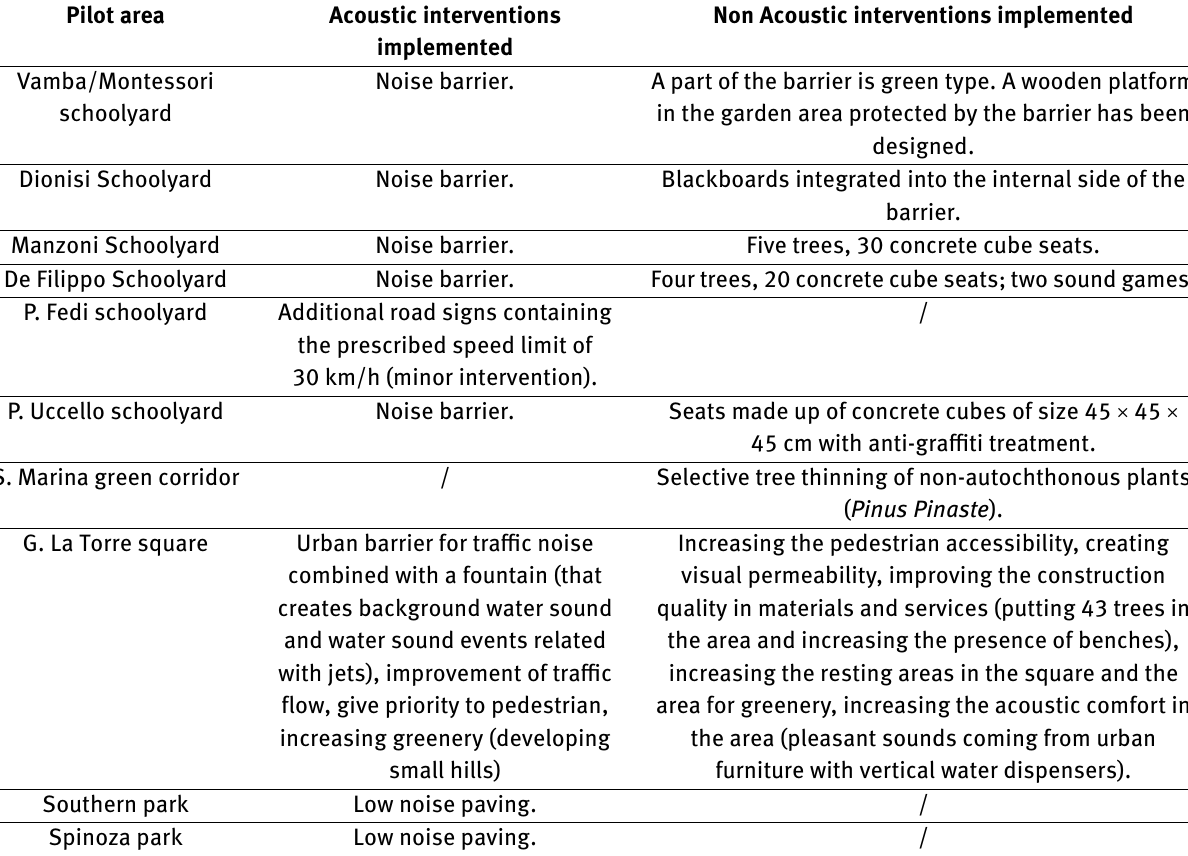
Table 1: Interventions carried out in the pilot cases.